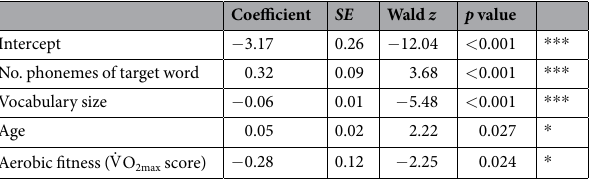
Table 2. Summary of the mixed effects logistic regression model predicting tip-of-the-tongue occurrence in the older adults. Note: N = 1680, AIC = 998.7, log-likelihood = − 492.3, *** < 0.001 ** < 0.01 * < 0.025. This model